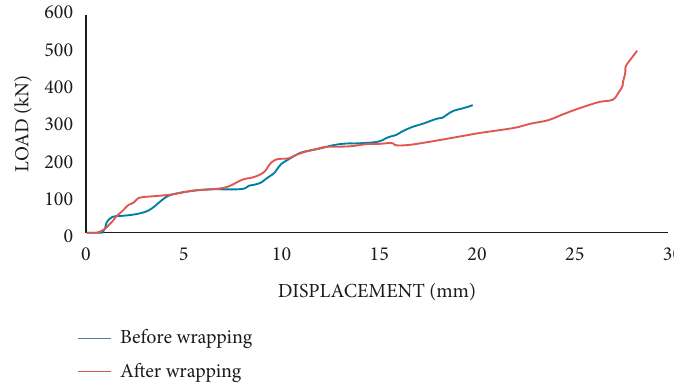
Figure 15: Load-deflection behavior of GG15 specimens before and after wrapping.